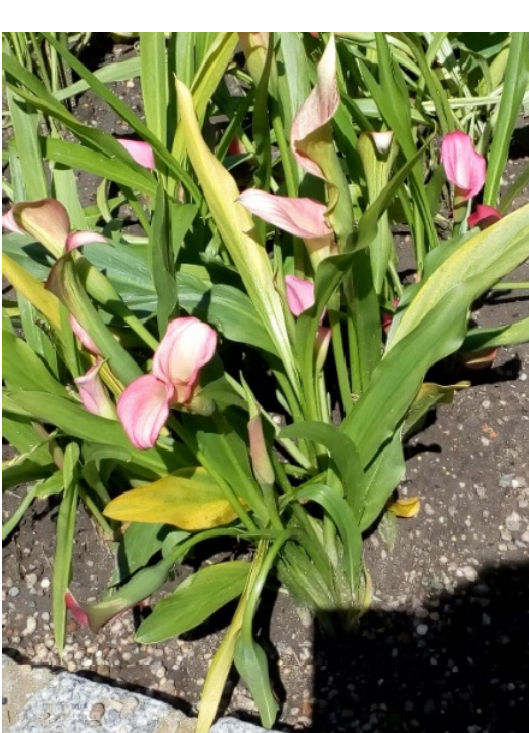
Figure 7 . Soft rhizome rot in Zantedeschia (Beata Janowska 2017). Figure 7. Soft rhizome rot in Zantedeschia (Beata Janowska